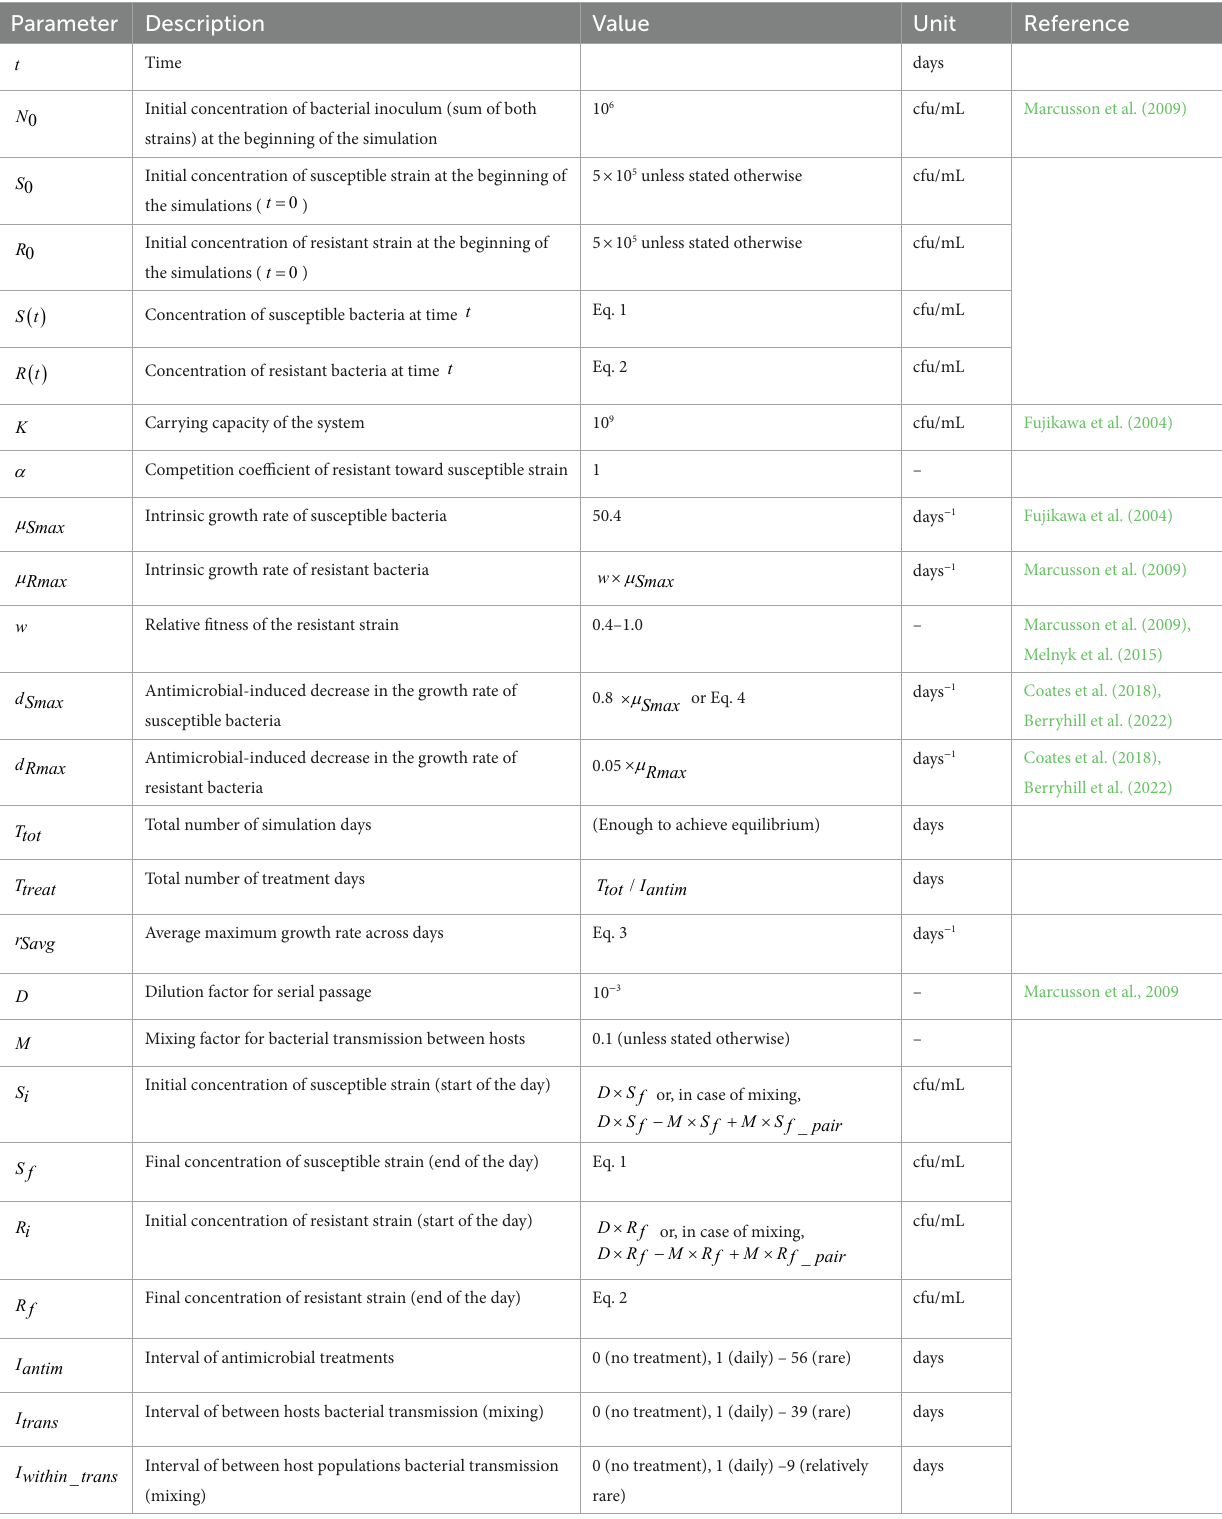
TABLE 1 Glossary of